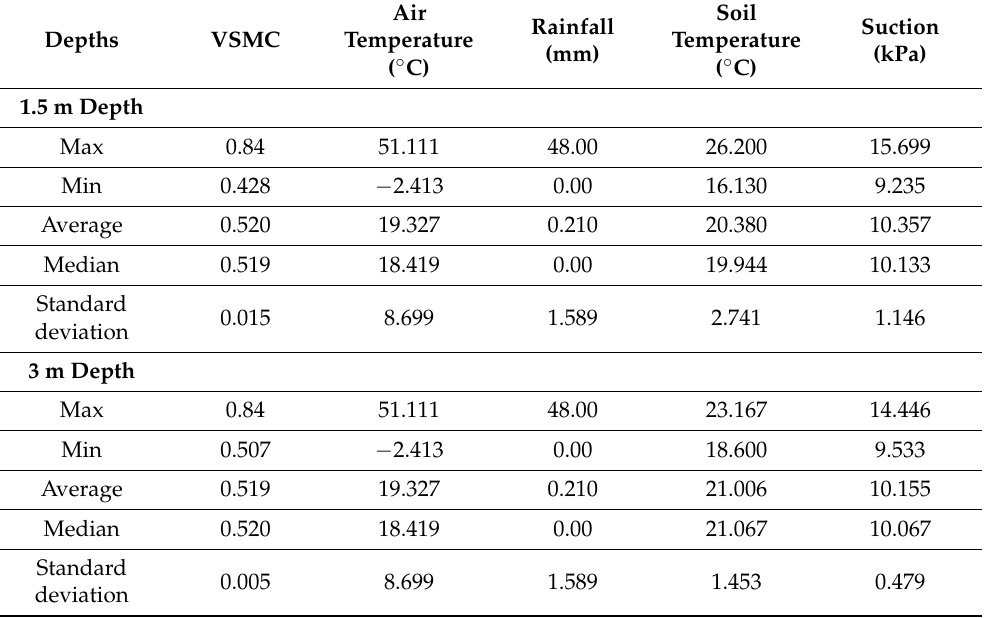
Table A2. Preliminary detailed statistics for the constructed dataset HWS